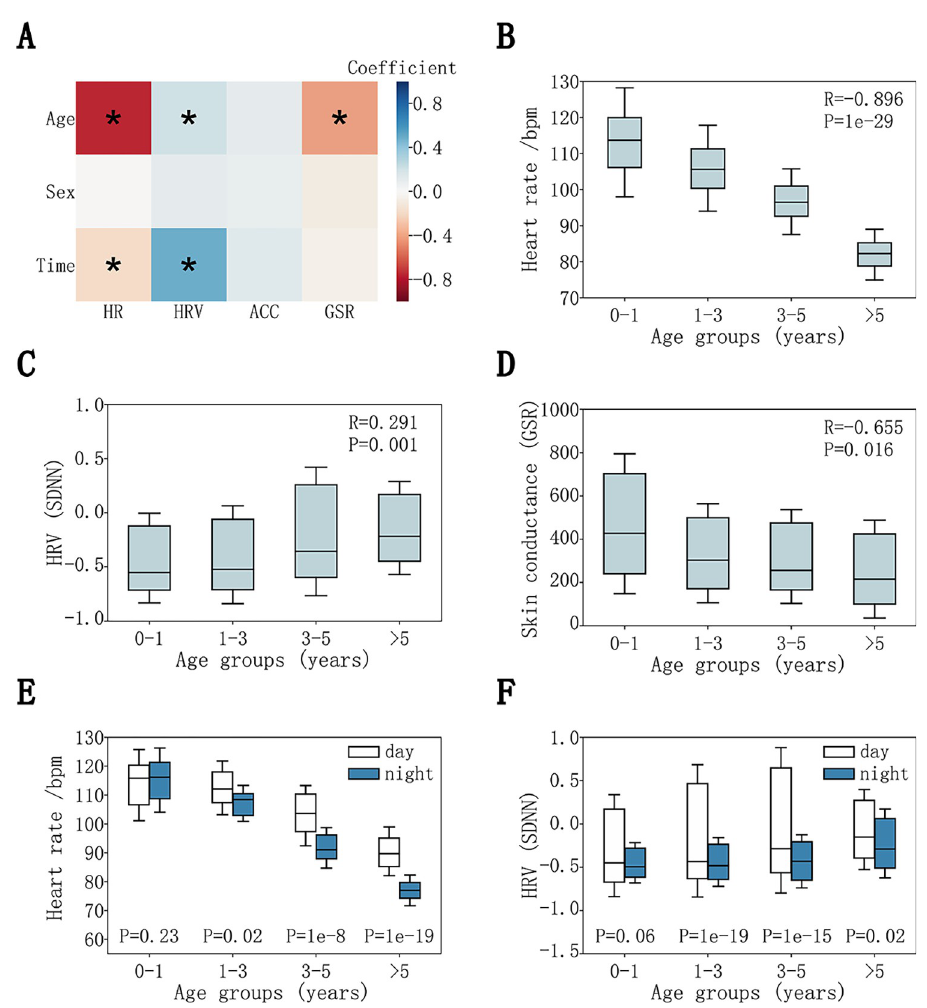
Fig 2. Physiological dynamics associated with childhood development. ( A ) Multiple Linear Regression (MLR) analysis conducted on 4 physiological signals (HR, GSR, ACC magnitude and SDNN variables in HRV analysis) by controlling for age, sex, and the time of the day. ( B ) HR signals associated with childhood development. ( C ) SDNN signals associated with childhood development. ( D ) GSR signals associated with childhood development. ( E ) HR signals associated with childhood development during the time of the day. ( F ) SDNN signals associated with childhood development during the time of the day.